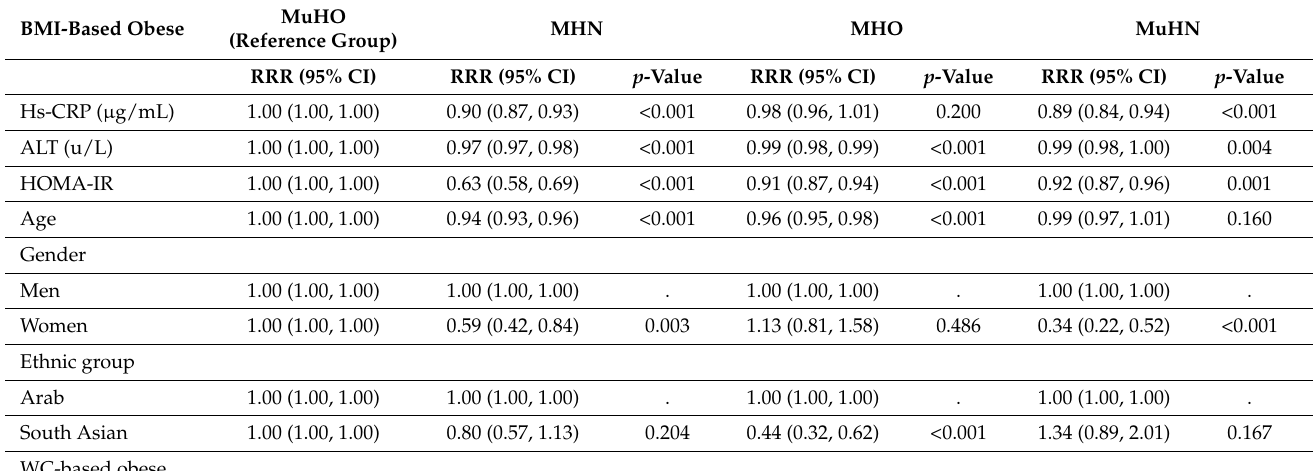
Figure 1. The dash red line for hs-CRP is the population cut-off point 3 µ g/mL; ALT (46 µ L) and HOMA-IR (3.5) is the 75th percentile of the population values. The distribution of hs-CRP, ALT, and HOMA-IR by age group and phenotypes of metabolically healthy/unhealthy obesity. Table 3. Association between hs-CRP, ALT, and HOMA-IR, and the metabolically healthy and unhealthy obese